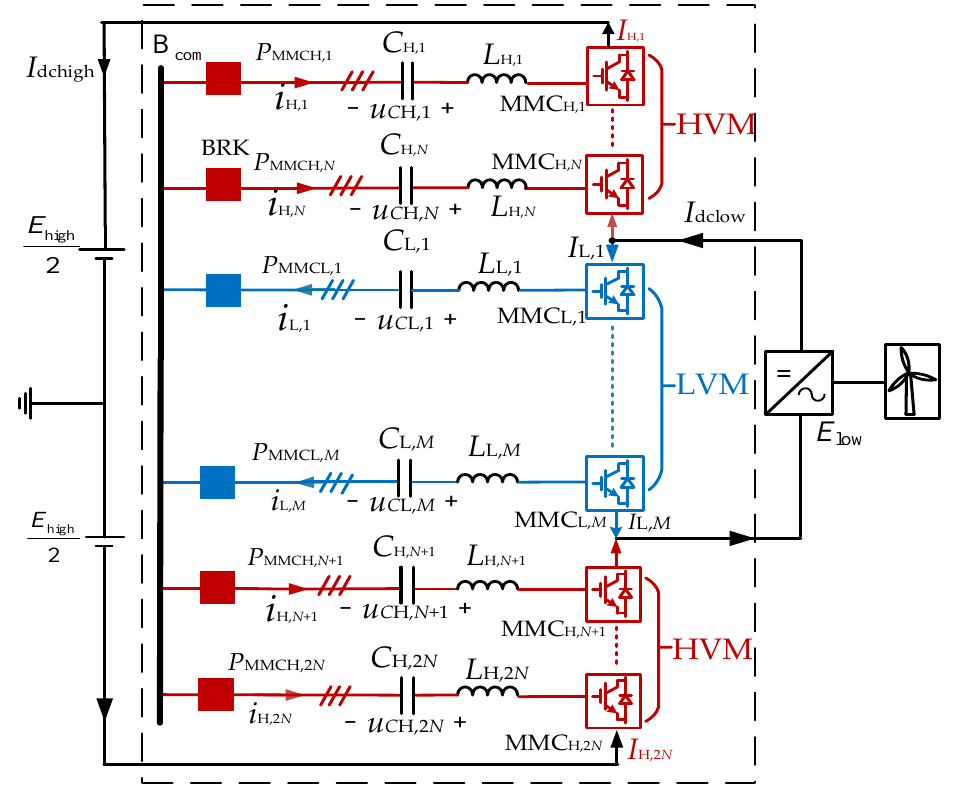
Figure 2. Schematic diagram of the MCAT topology.